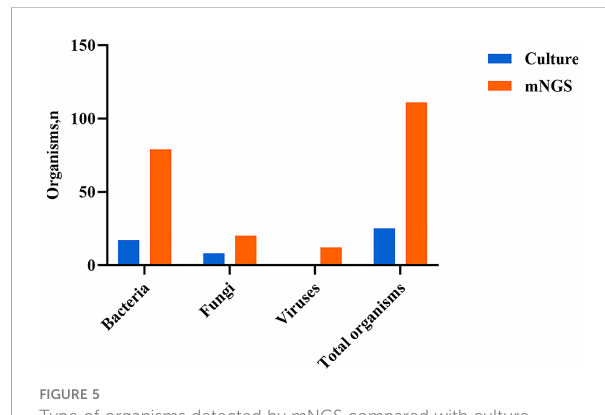
FIGURE 4 Concordance between mNGS and culture for pathogen detection. The pie chart demonstrated the positivity distribution of mNGS and culture for all samples. 61.69% were positive by mNGS, 0% by culture, 26.30% by both, and 12.01% were both negative. mNGS, metagenomic next-generation sequencing.